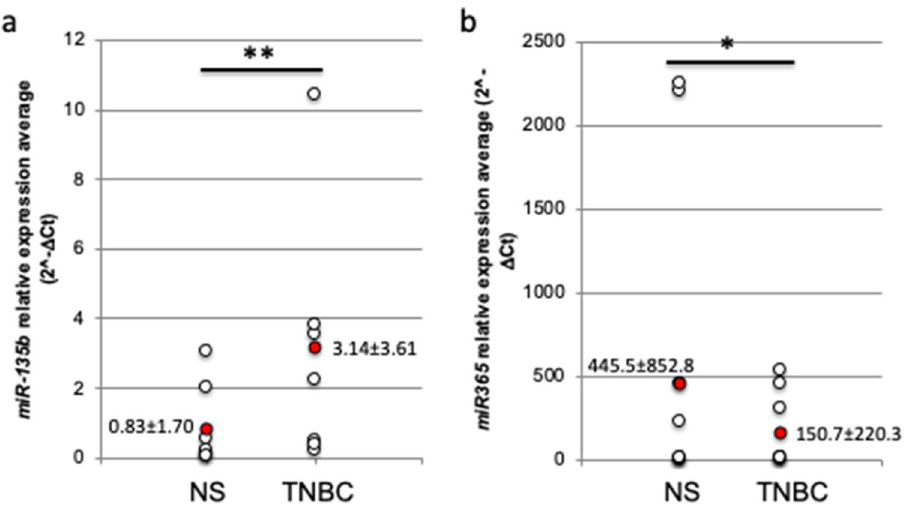
Figure 5. miR-135b and miR-365 are differentially expressed in human basal BC samples. miR-135b ( a ), and miR-365 ( b ) expression levels were evaluated by RT-qPCR analysis in human basal BC (TNBC) or surrounding healthy tissue samples (normal samples, NS). The average of three independent experiments is depicted in red. T test p value < 0.05 (*), 0.01 (**).